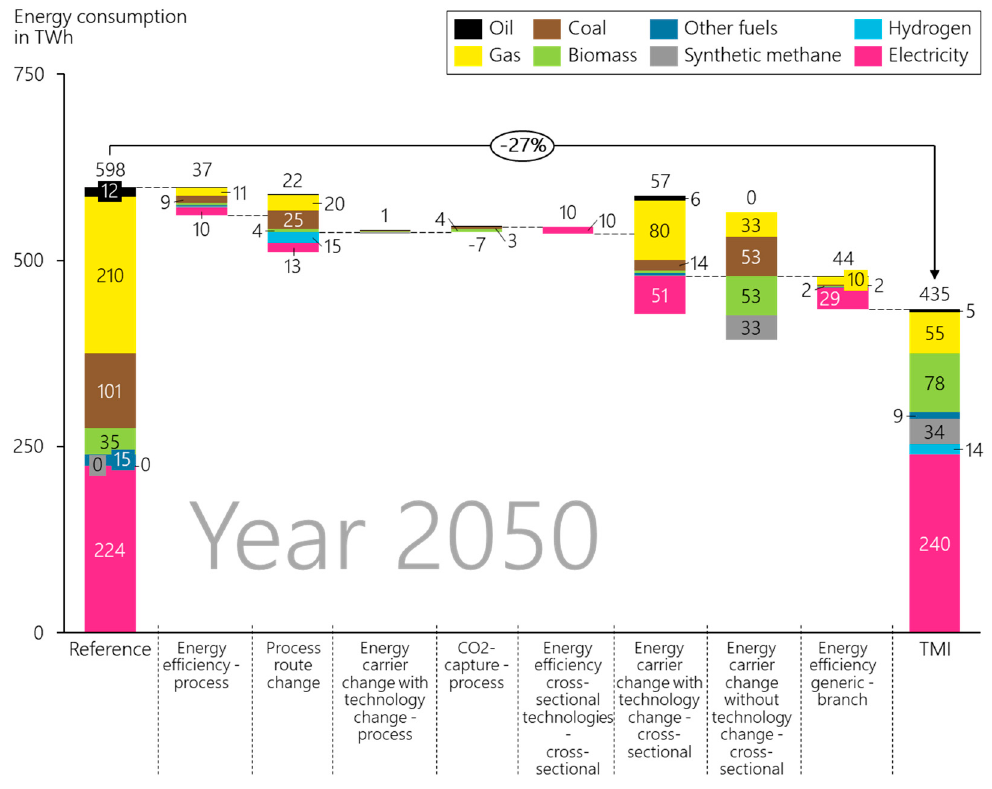
Figure 7. Difference in industry’s final energy consumption between Reference and TMI-Scenario. Figure 7. Di ff erence in industry’s final energy consumption between Reference and